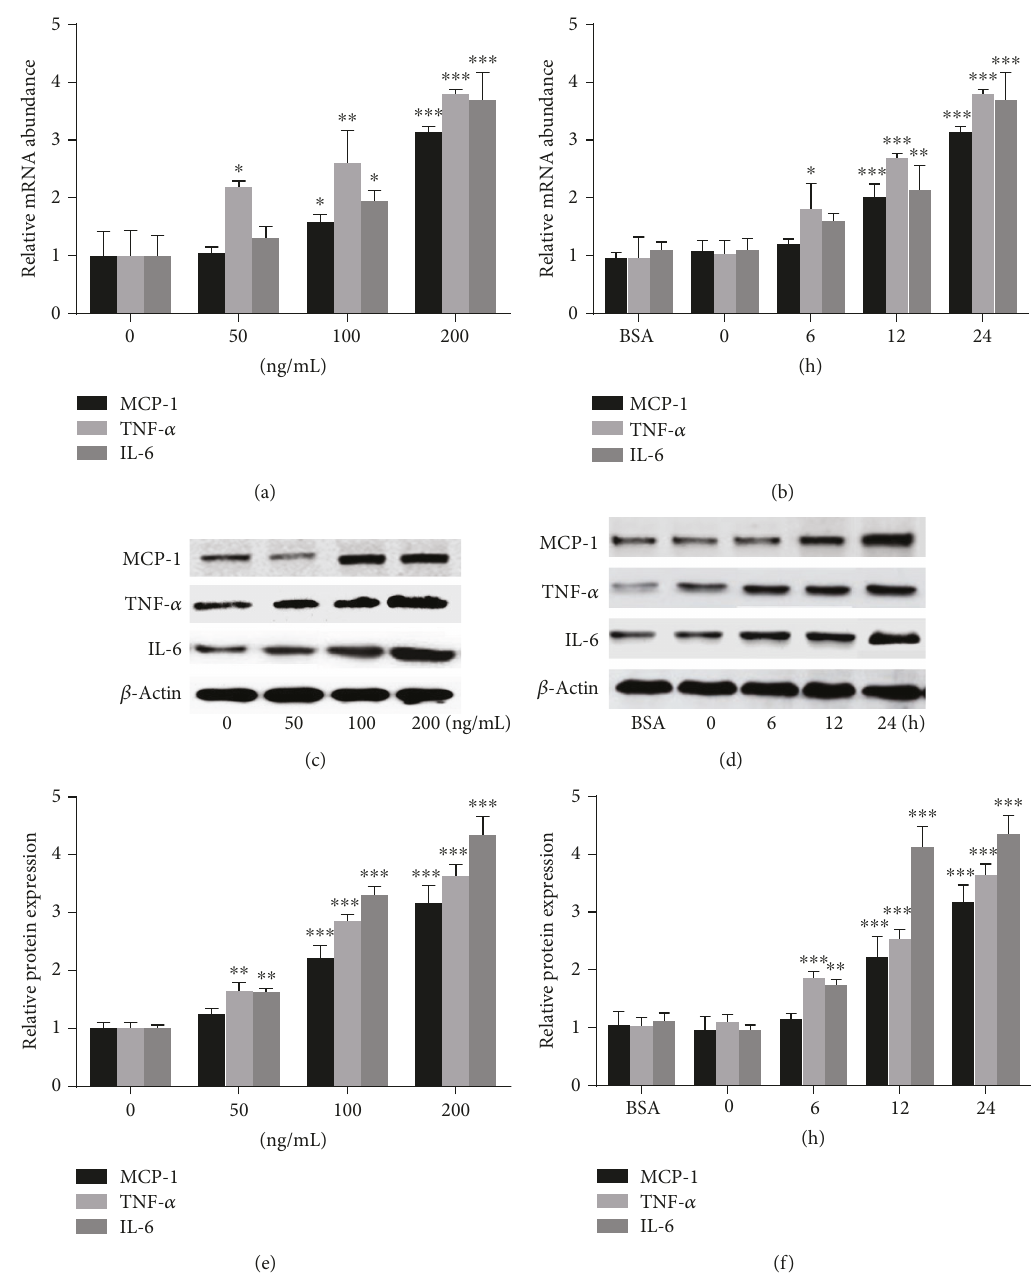
Figure 1: Dose-dependent and time-dependent e ff ects of PAPP-A on MCP-1, TNF- α , and IL-6 expressions in RAW264.7 macrophages. (a, c, e) RAW264.7 macrophages were treated with various concentrations of PAPP-A for 24h, respectively. (b, d, f) Cells were treated with 5mg/mL BSA for 24h or with 200 ng/mL PAPP-A for di ff erent durations, respectively. (a, b) MCP-1, TNF- α , and IL-6 mRNA expressions were measured by RT-qPCR. (c, d, e, f) MCP-1, TNF- α , and IL-6 protein expressions were measured by Western blot assays. All the results are expressed as the mean + SD from three independent experiments, each performed in triplicate. ∗ P < 0 05 vs. baseline, ∗∗ P < 0 01 vs. baseline, and ∗∗∗ P < 0 001 vs.